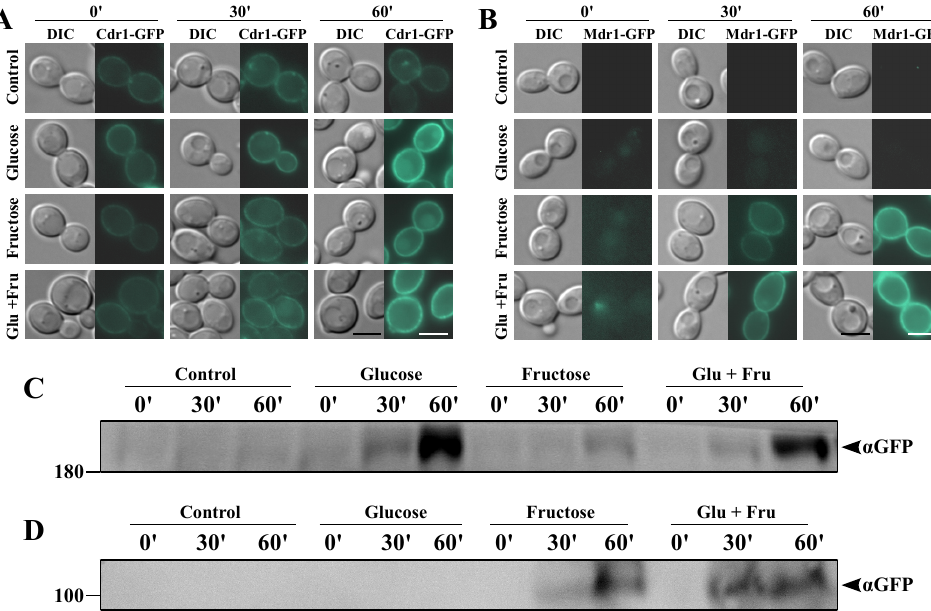
Figure 5. Fluorescence micrographs showing the subcellular localization of ( A ) Cdr1p-GFP in the C. albicans strain KS052 (CAF2-1 CDR1-GFP ) or ( B ) Mdr1p-GFP in the C. albicans strain KS070 (CAF2-1 MDR1-GFP ). Scale bar = 3 µm. Immunoblot analysis of ( C ) Cdr1p-GFP in C. albicans KS052 or ( D ) Mdr1-GFP in C. albicans KS070. In all the presented ex- periments, the C. albicans strains were grown in a yeast nitrogen base glucose (YNBG) medium for 8 h at 28 °C; starved in a HEPES-NaOH buffer for 1 h at 28 °C; and induced with 0.2% glucose, 0.006% fructose, or both sugars simultaneously (Glu + Fru) for 30 or 60 min.